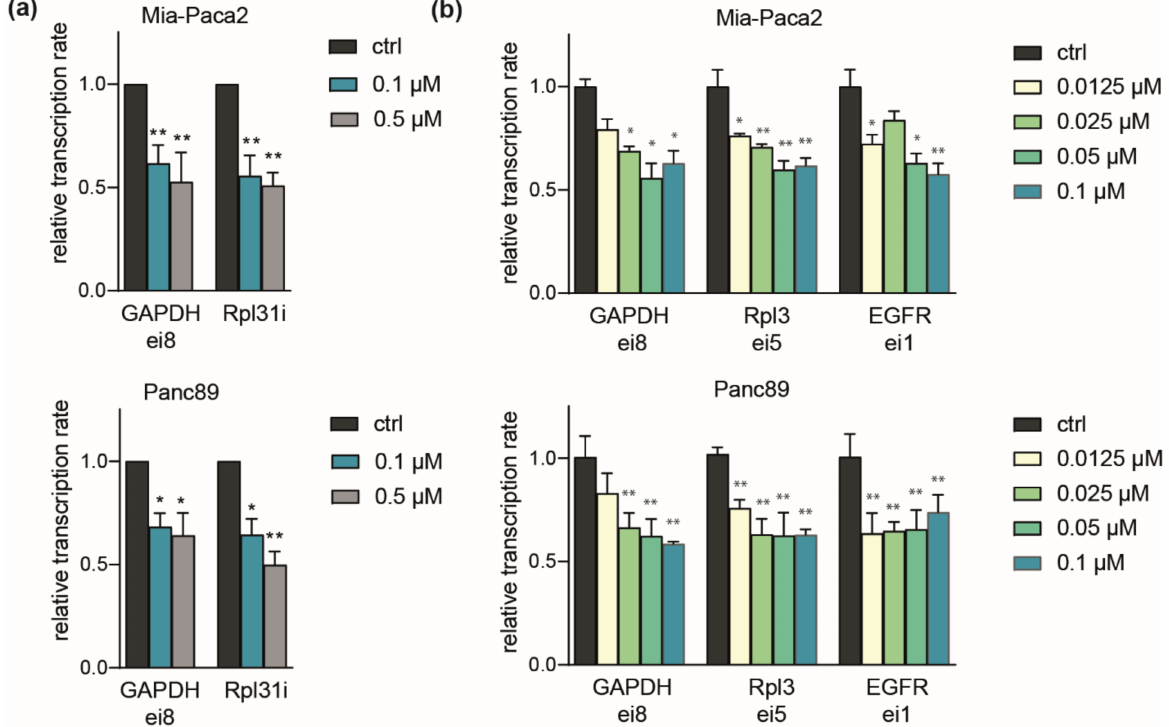
Figure 4. Comparable impact of CDK7 on transcription in Mia-Paca2 and Panc89 cells. ( a ) Mia- Paca2 and Panc89 cells were treated with 0.1 µ M and 0.5 µ M LDC4297 for 2 h and transcription rates determined by RT-qPCR using primers targeting intronic RNA directly (i) or RNA at exon- junctions (ei). Results were normalized to spike-in RNA (Luciferase). Shown is the mean ± SD ( n = 4). ( b ) Mia-Paca2 and Panc89 cells were treated with the indicated concentrations of LDC4297 [ µ M] for 2 h and analyzed as described in ( a ). Shown is the mean ± SD ( n = 4). Significance was analyzed by two-sided Student’s t test: * p ≤ 0.05; ** p ≤